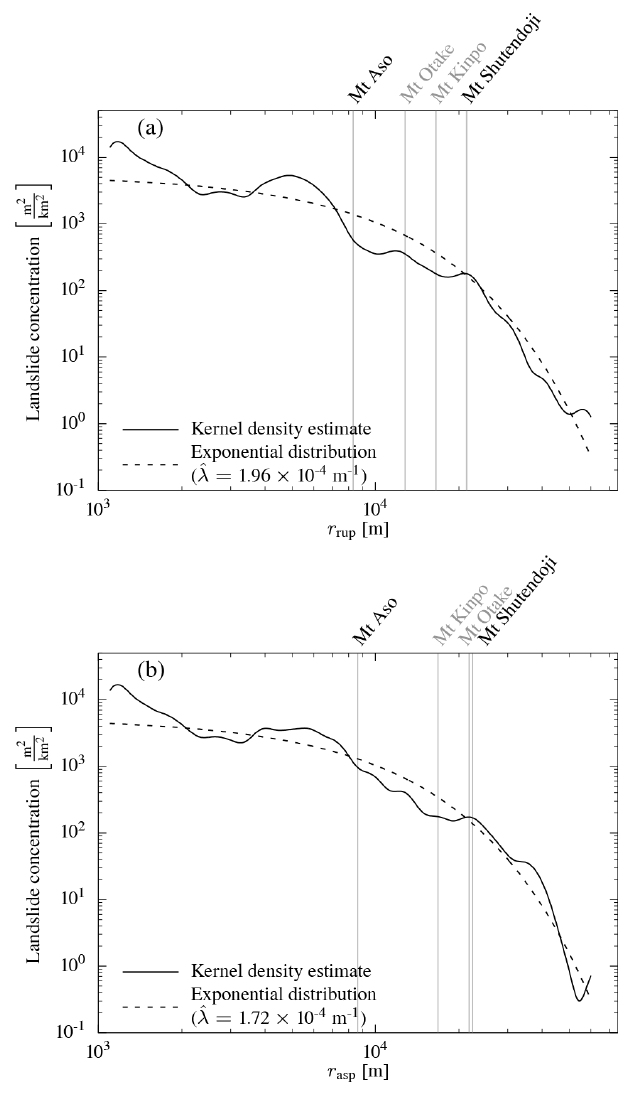
Figure 5. (a) Landslide concentration with (a) rupture distance r rup and (b) asperity distance r asp of the Kumamoto earthquake land- slides. The rate parameter of the exponentially decaying landslide concentration is estimated by maximum likelihood. The distances to the four peaks shown in Fig. 1 are given. Densities change lit- tle with distance metric, as highlighted by the similar kernel den- sity estimates and the near-identical rate parameter estimates ˆ λ . The landslide concentration for Mt Aso depends more on the distance metric than for the other three locations. The more distant moun- tains have very similar concentrations despite differences in dis- tances (in particular Mt Otake). However, when compared to Fig. 7, Mt Shutendoji has a higher landslide concentration than Mt Kinpo and Mt Otake, despite being the farthest